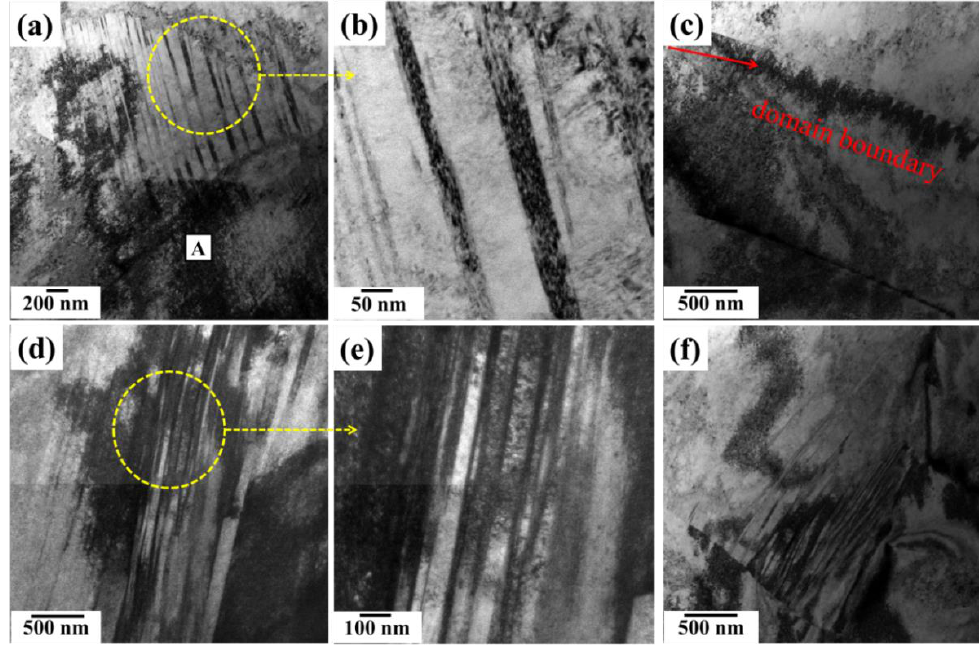
Figure 4. TEM representative micrographs of deformed specimens of low-density steel at various strain rates; ( a – c ) at 3030 s − 1 ; ( d – f ) 4083 s − 1 .